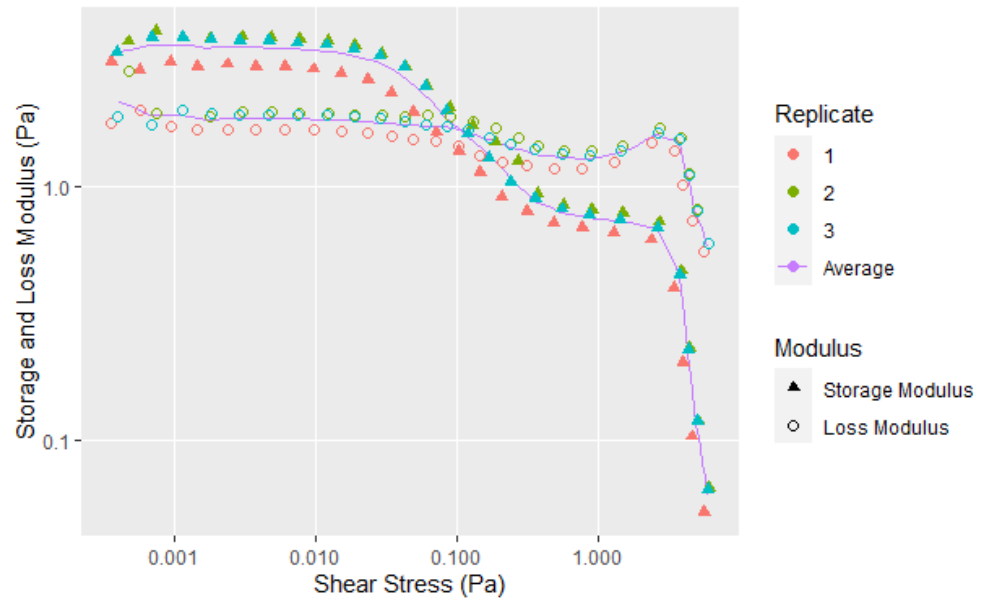
Figure A2. Individual amplitude sweep data for mixtures of 90 PDI flour with 1 h mixing time and 15% solid content.